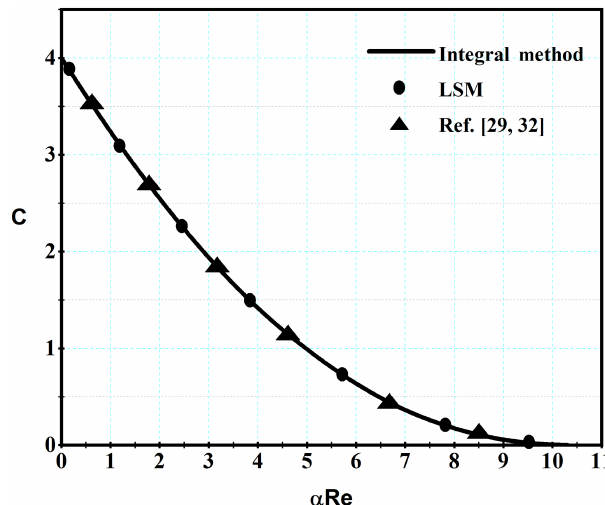
Figure 2. The C – α Re curve comparison between the present work and references (Schlichting and Gersten, 2000; Withe,